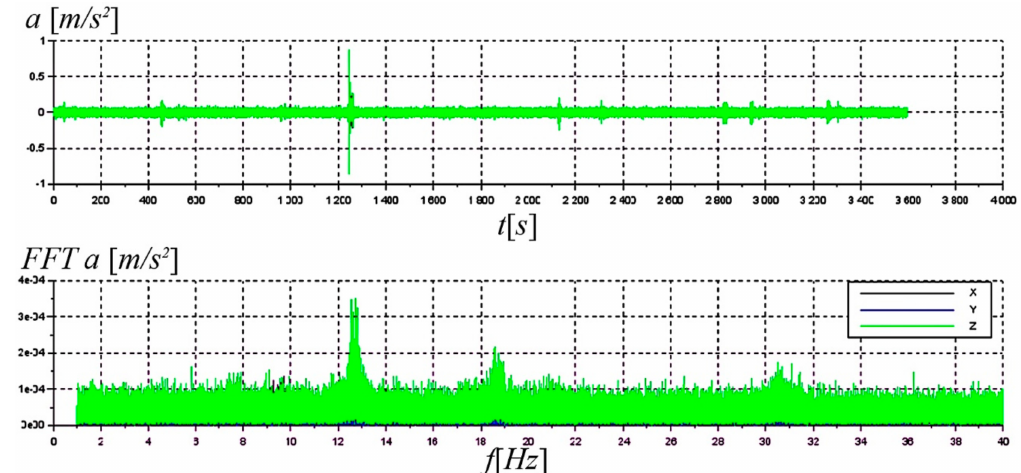
Figure 27. Example data of vibration monitoring with FFT